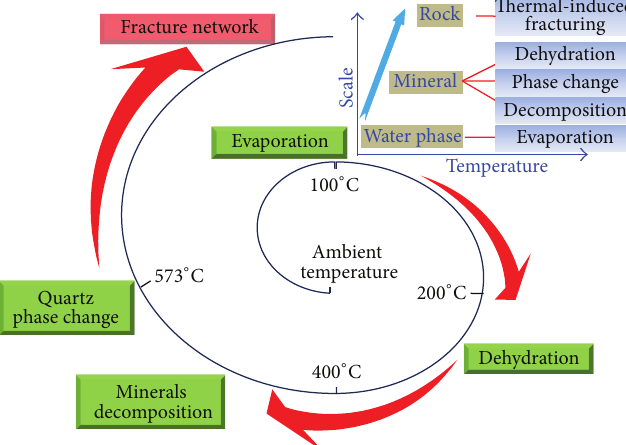
Figure 8: Mechanisms of heat treatment for tight